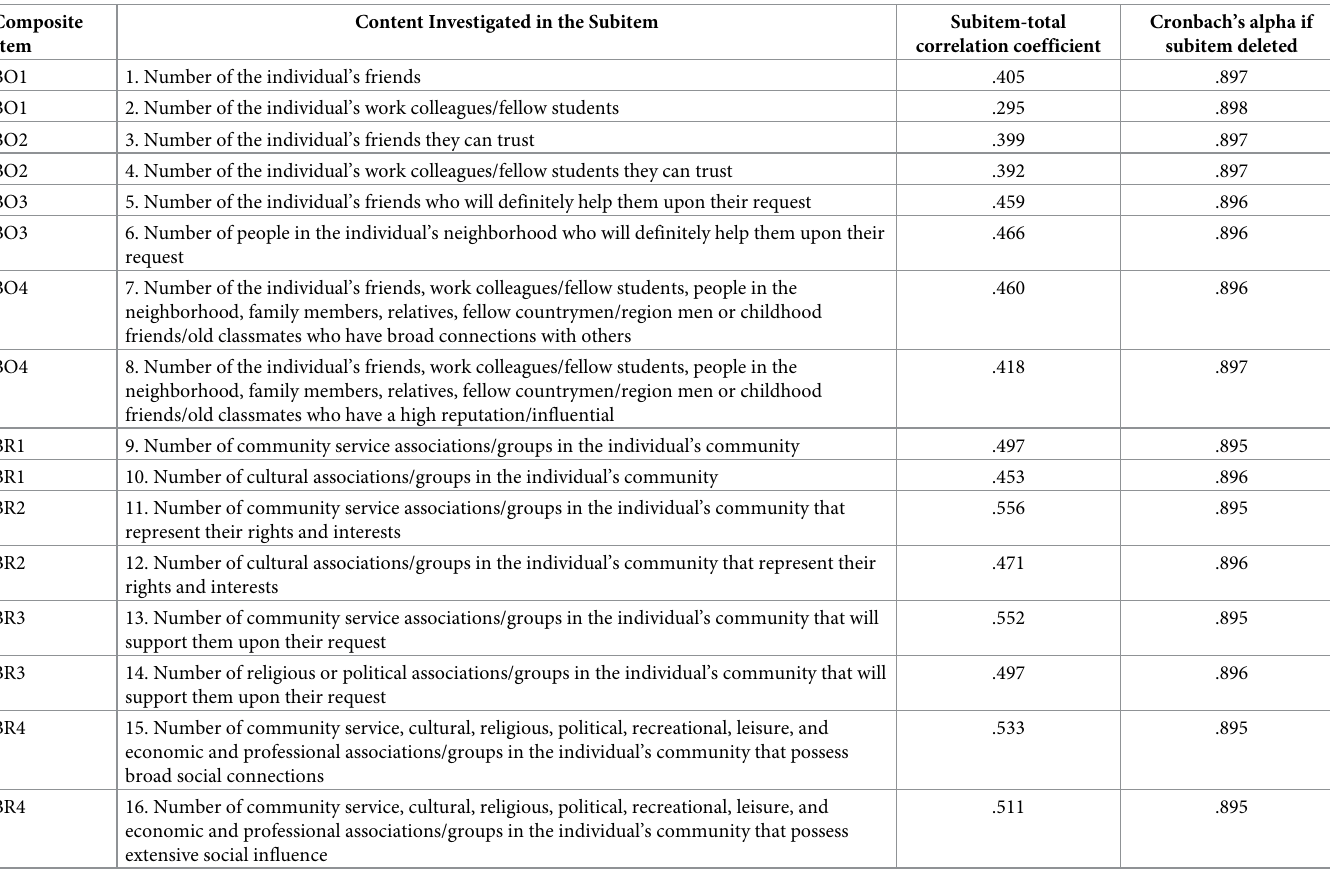
Table 1. Subitem-total correlation coefficients and Cronbach’s alpha if subitem deleted for the 16 subitems organized in eight composite items of the personal social capital scale-brief Italian version. Composite